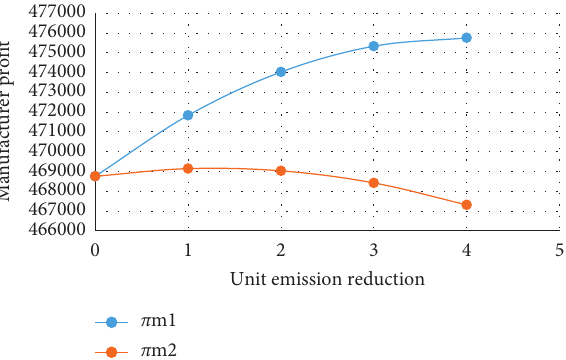
Figure 7: Retailer profit comparison